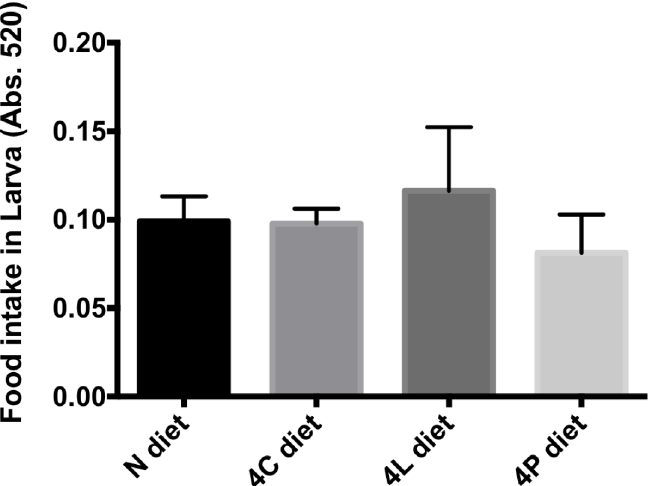
Fig 2. Food intake of flies fed enriched diets. Animals reared on the indicated diets were allowed to feed on red-colored food for a defined period of time. The amount of red food coloring in a homogenate was measured as absorbance at 520 nm. 20 larvae per diet were analyzed after a 30-min feeding period on the indicated synthetic diet. No significant differences where observed by Ordinary one-way ANOVA. Error bars, standard